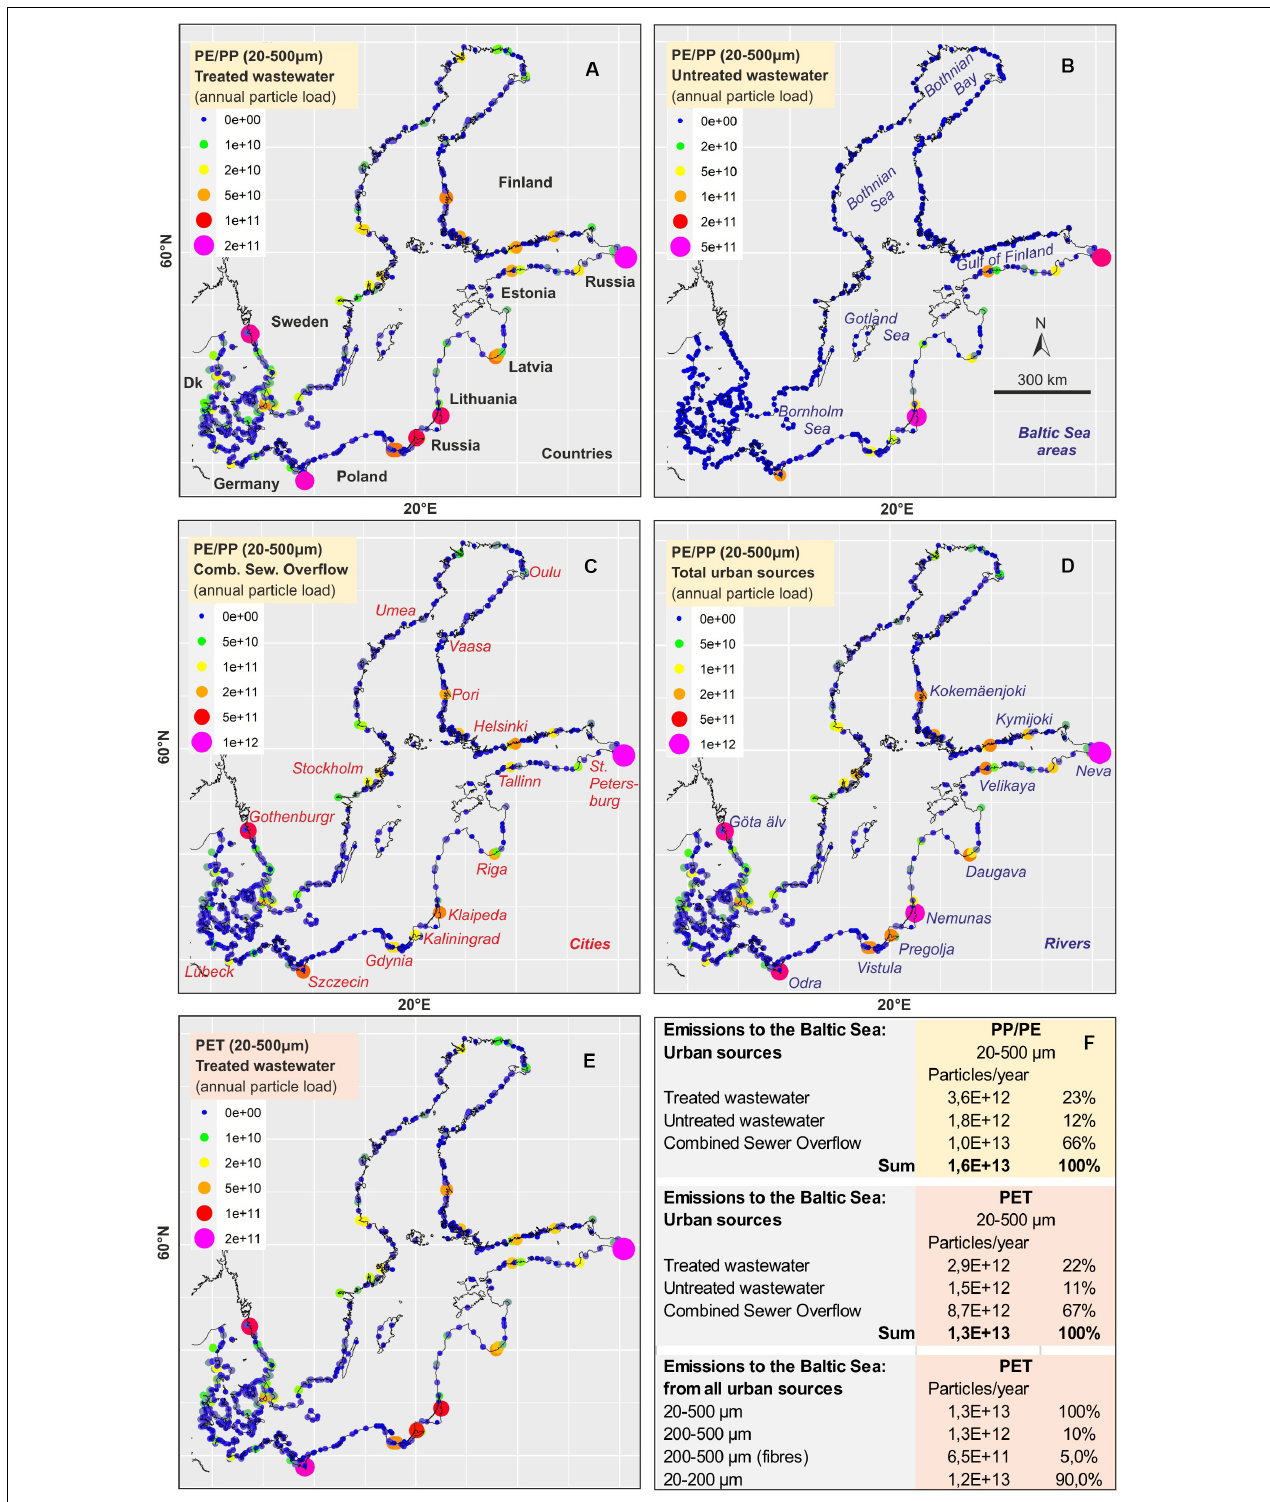
FIGURE 2 | Emissions of Polyethylene (PE)/Polypropylene (PP) and Polyethylenterephthalat (PET) microplastic particles (20–500 µ m size fraction) from different urban sources to the Baltic Sea assuming no retention. Treated wastewater covers emissions from effluents of wastewater treatment plants (WWTPs; A,E ). Untreated wastewater means emissions from populations not connected to WWTPs (B) . Emissions from combined sewer overflow systems (CSS), largely untreated, are kept separately (C) . Total urban emissions (D) are the sum of WWTPs, untreated wastewater and CSS. Total annual emissions from urban sources to the Baltic Sea (F) .